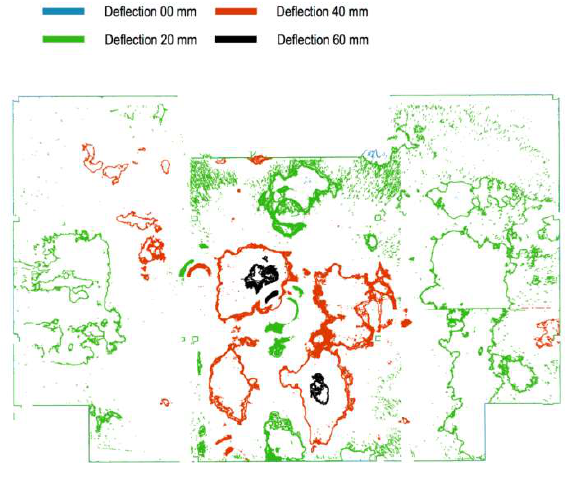
Figure 20: First floor slab deflection